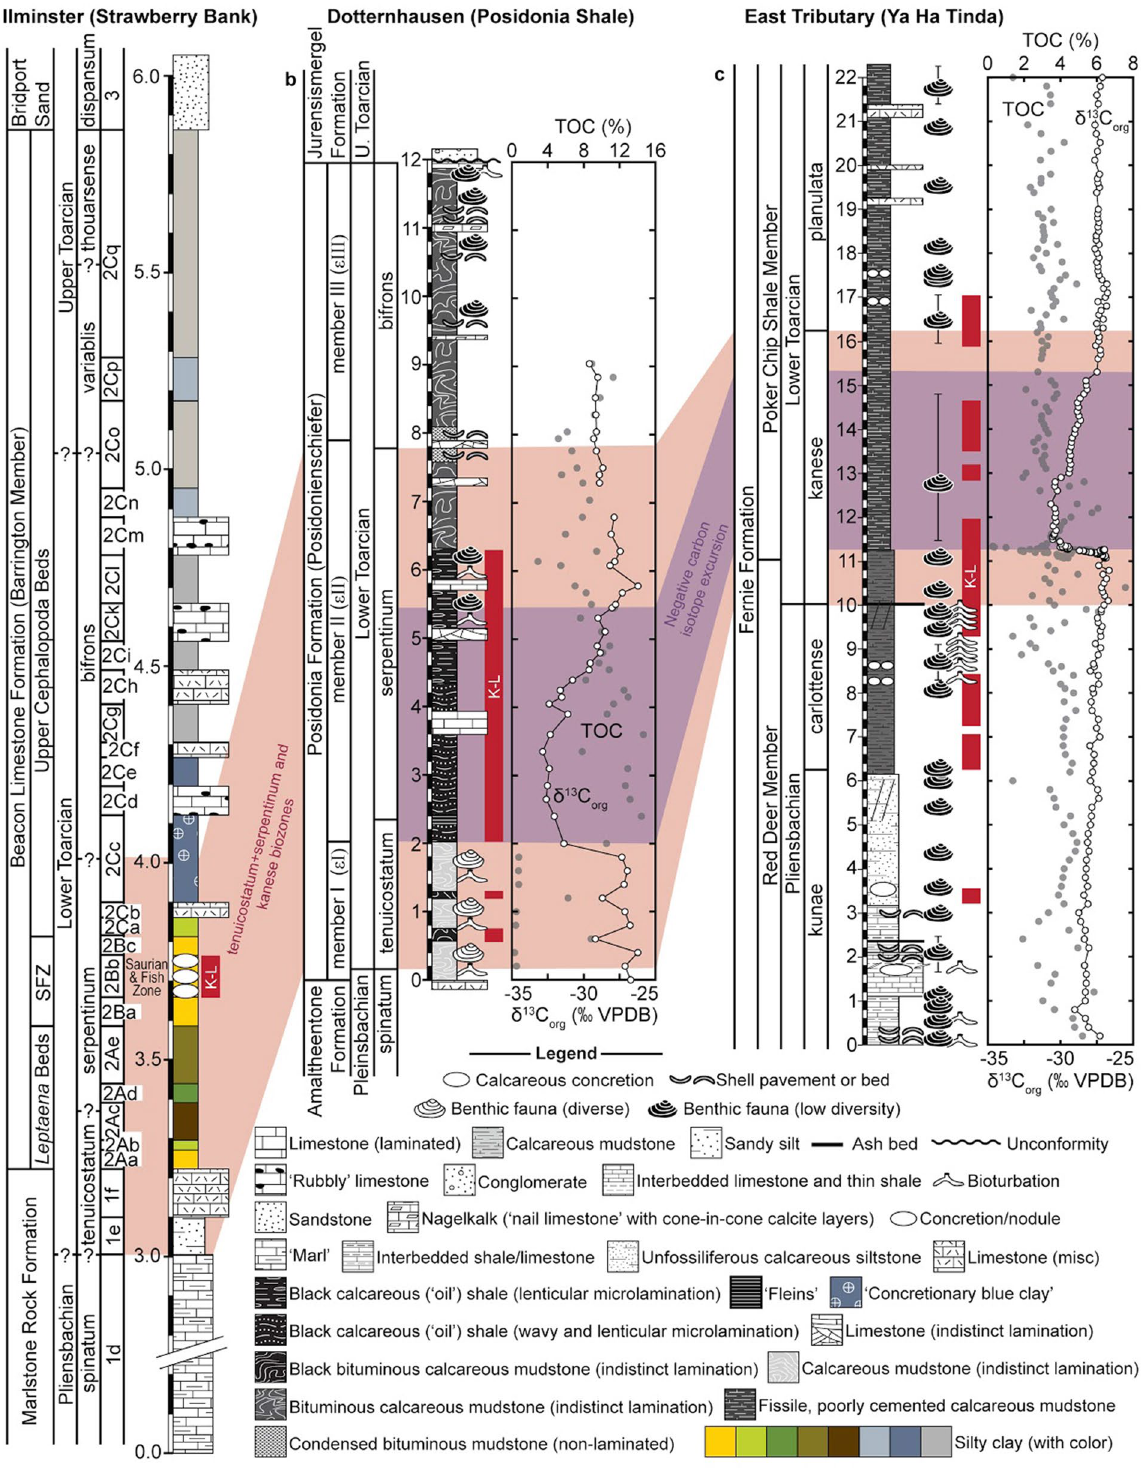
Figure 2. Stratigraphy of three sections with exposures of Lower Jurassic (Toarcian) Konservat-Lagerstätten (K-L). ( a ) Strawberry Bank (Ilminster, UK) 36 . ( b ) Dotternhausen (Baden-Württemberg, Germany) 16 . ( c ) East Tributary near Ya Ha Tinda Ranch (Alberta, Canada) 9 . Each section includes a sedimentary log along with names of lithostratigraphic (e.g. formations, members, beds, etc.), chronostratigraphic (sub-stage), and biostratigraphic (fossil biozone and subzone) units. Chemostratigraphic data, in the form of stable carbon isotope (δ 13 C relative to the Vienna Pee Dee Belemnite) and total organic carbon (TOC) measurements, are provided with the Dotternhausen and East Tributary logs. The TOAE is correlated with the tenuicostatum and serpentinum biozones in Europe and the kanense biozone in North America. Shaded areas illustrate correlations between the biozones and negative carbon isotope excursion caused by the event. Locations of Konservat- Lagerstätten are illustrated by vertical red bars (labelled with “K-L”). Values in logs are provided at meter scale. “Mudstone” refers to terrigenous mudstone (rather than